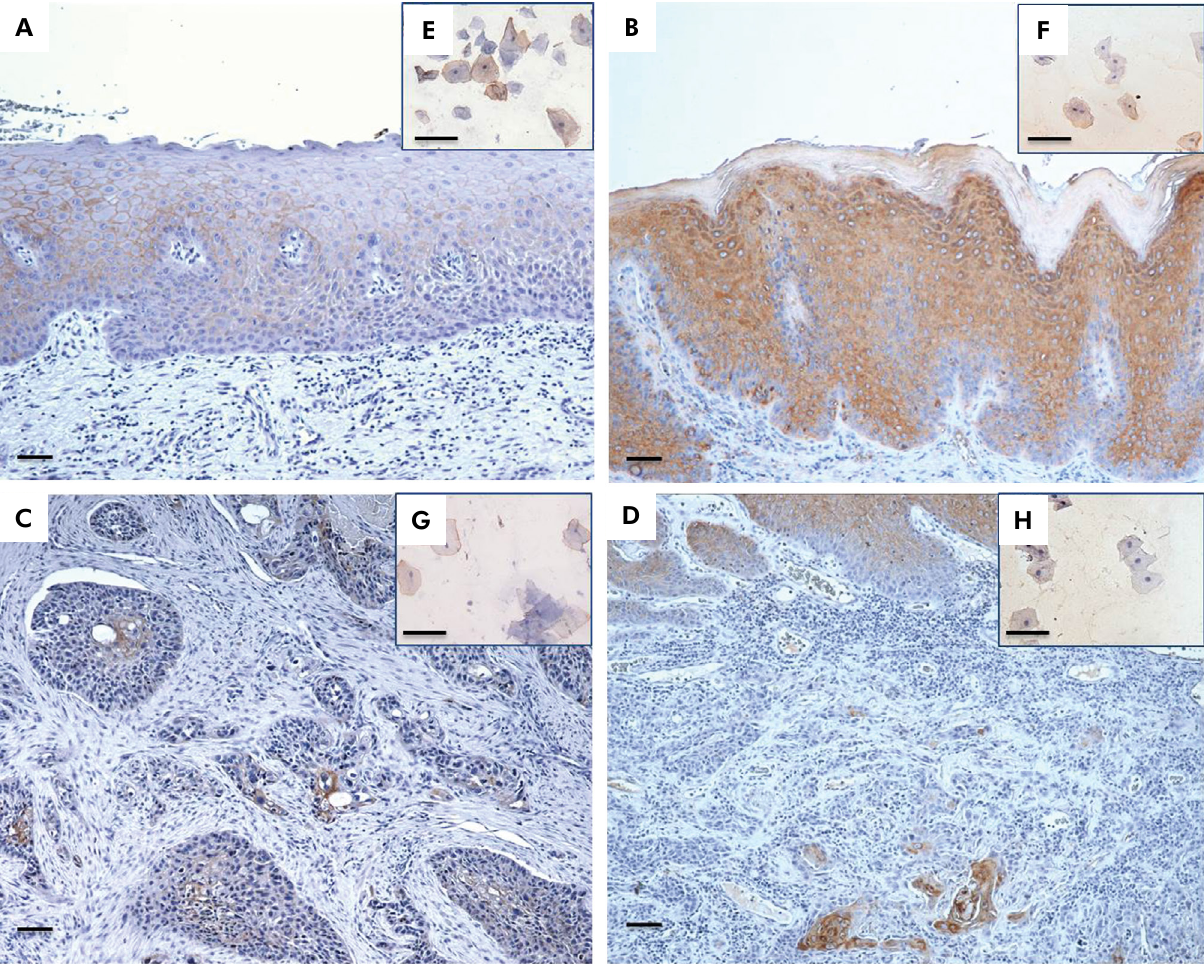
Figure 1. (A) Immunohistochemical expression of E-cadherin in the leukoplakia group, showing epithelial hyperplasia and acanthosis, and poor E-cadherin staining (100X). (E) In the upper right image, the cytologic smear indicates poor staining of E-cadherin in the leukoplakia group (400X). (C) Immunohistochemical expression of E-cadherin in the squamous cell carcinoma group, showing poor and focal staining at the center of tumor islands (100X). (G) In the upper right image, the cytologic smear indicates poor staining of E-cadherin in the squamous cell carcinoma\group (400X). (B) Expression of involucrin in the leukoplakia group, with epithelial hyperplasia and hyperkeratosis, intense staining along the epithelium, except in the basal and suprabasal layers (100X). (F) In the upper right image, the cytologic smear indicates poor staining of involucrin in the leukoplakia group (400X). (D) Immunohistochemical expression of involucrin in the squamous cell carcinoma group, with focal staining only at the center of tumor islands, with keratin formation (100X). (H) In the upper right image, the cytologic smear indicates poor staining of involucrin in the squamous cell carcinoma group